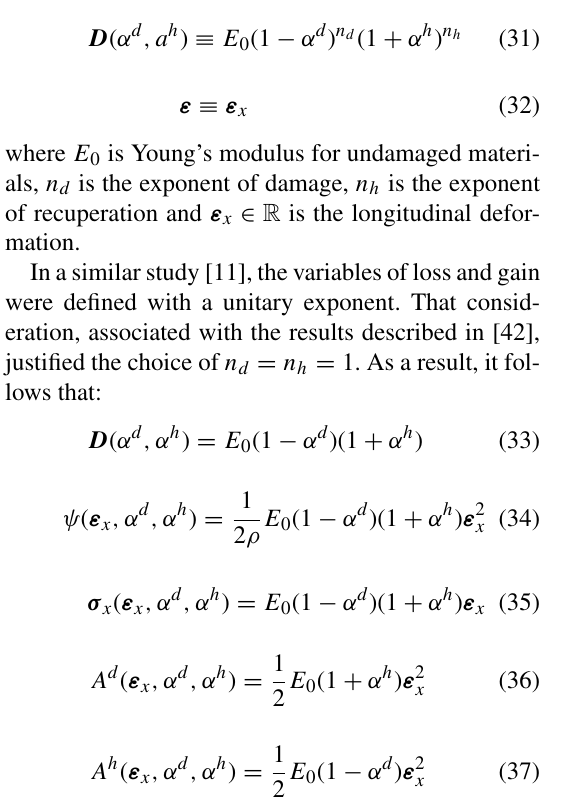
Fig. 3. Generalized stress diagram indicating the thermodynami- cally admissible regions for the